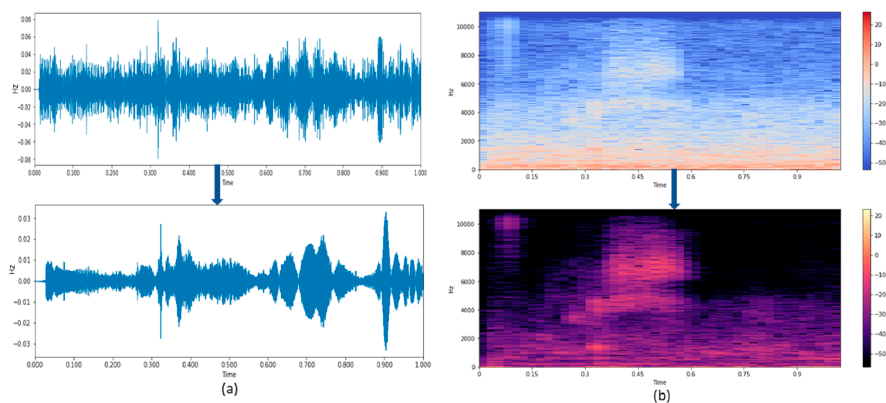
Figure 8. ( a , b ) Time waveform and Spectrogram of speech signal using subspace.